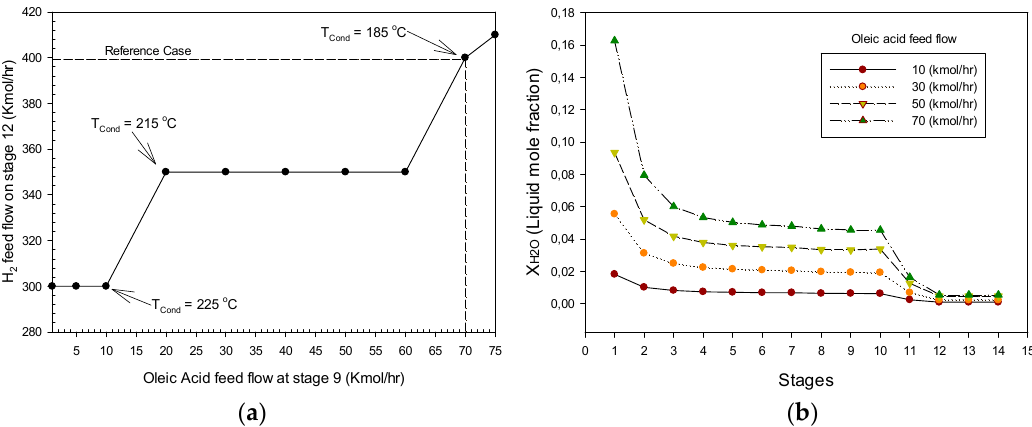
Figure 6. ( a ) Hydrogen feed flow required on stage 12. Oleic acid-petro-diesel mixture fed at stage 9. ( b ) Water liquid composition profile.